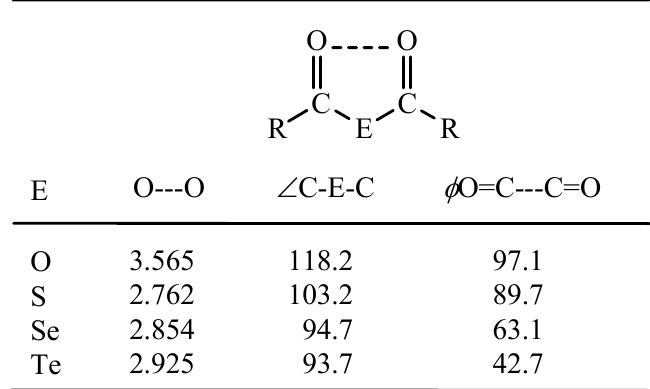
Table 3. C=O---O=C distances and < C-E-C and interplanar angles ( φ O=C---C=O) in (2- H CO) E (E= O, S, Se, MeOC 6 4 2